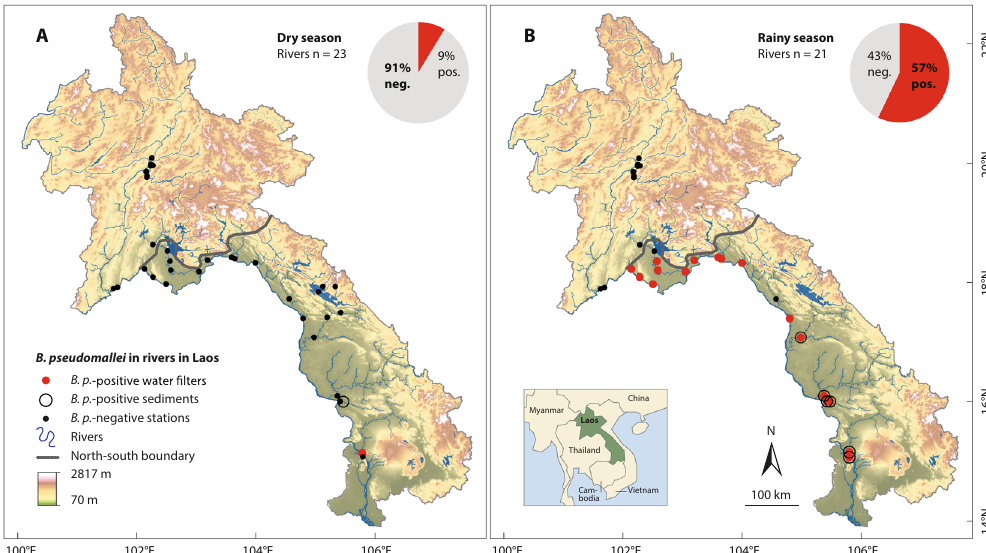
Figure 1. B . pseudomallei ( B . p .)-positive and -negative stations and rivers in the dry season ( A ) and rainy season. ( B ) North-south boundary based on 38,39 , map background based on elevation data (U.S. Geological Survey, https://earthexplorer.usgs.gov; Central Intelligence Agency, https://www.cia.gov/library/publications/ the-world-factbook/index.html) and rivers/lakes/country shapefiles provided by the Centre for Development and Environment (CDE), CDE Lao Country Office, Laos. Geographic coordination system: WGS 1984, latitude and longitude in degrees; altitude of highest and lowest point in meters above mean sea level.